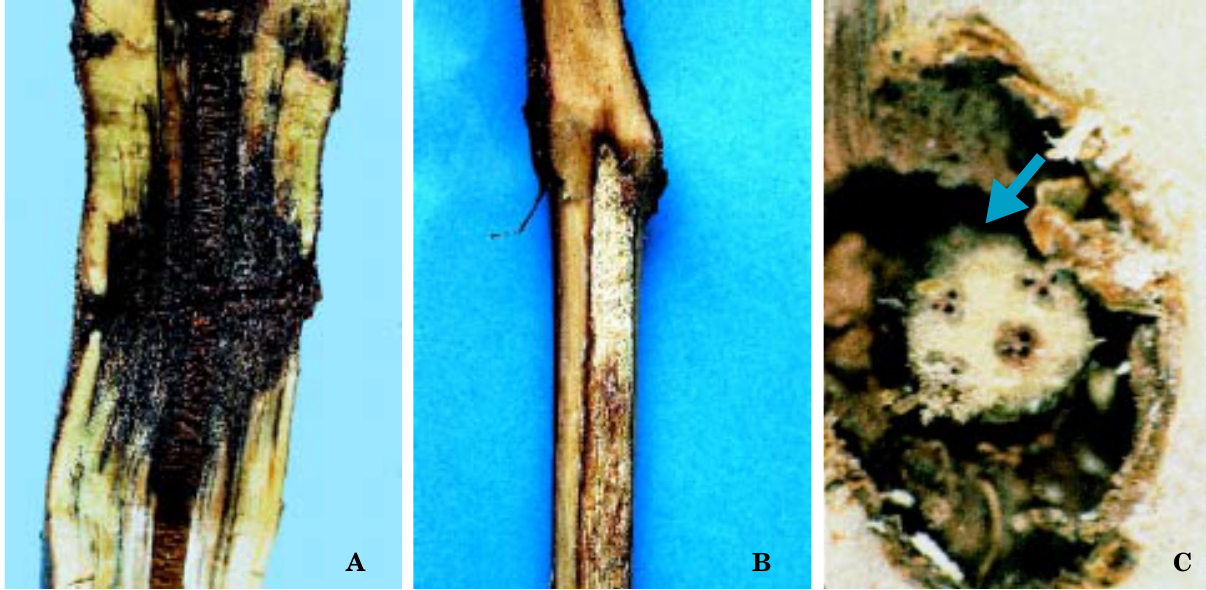
Fig. 1. A. Development of dark-brown wood discoloration in the wood of inoculated branches of grapevine cv. Sangio- vese all around the infection dowel colonised by F. punctata, two years after inoculation. B. White rot developed in the pith and woody tissues of a rootstock ‘Kobler 5BB’ grafted with ‘Italia’, two years after wound-inoculation with F. punctata . C. Detail of decayed woody tissue all around the infection dowel (2 mm in diam., arrow) colonised by F. punctata , six months after branch-inoculation of a 9-year-old grapevine cv. Matilde.